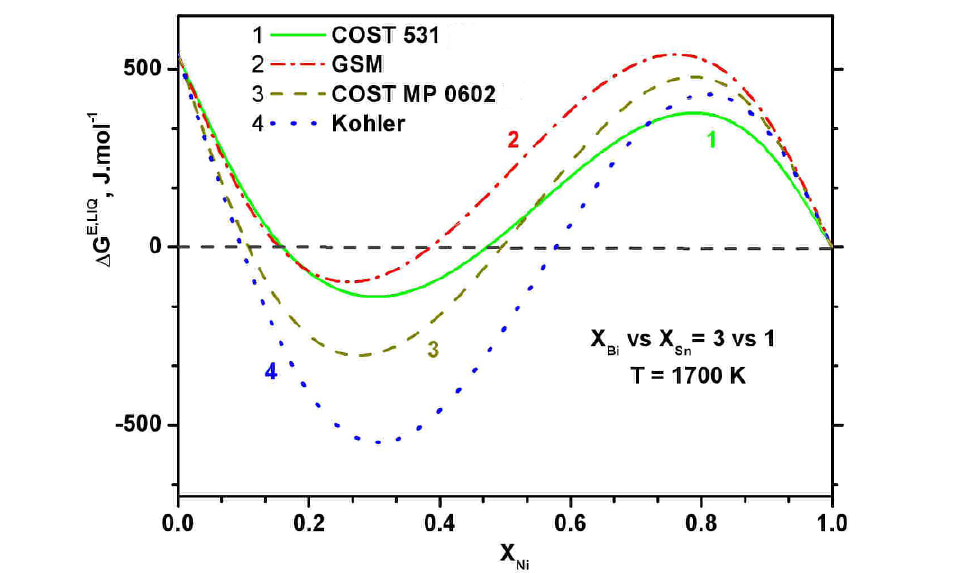
Figure 3. Ternary liquid phase molar Gibbs excess energies ( ∆ G E,Liq , J mol -1 ) calculated in this work according to various techniques: 1 – COST531([15], binary parameters only), 2 – this work, up to GSM [22,23], 3 – COST MP 0602 ([29], binary parameters only), 4 – this work, up to Kohler [20]. The calculations are done at 1700 K, along a section with constant molar Bi/Sn ratio equal to 3/1. X is the nickel mole fraction. Ni